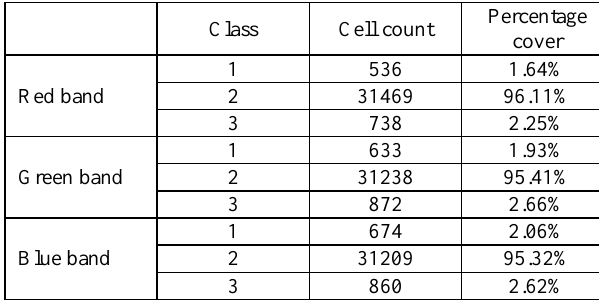
Table 2. Classification of difference maps on the RGB bands: cell count and percentage cover data for the three classes.